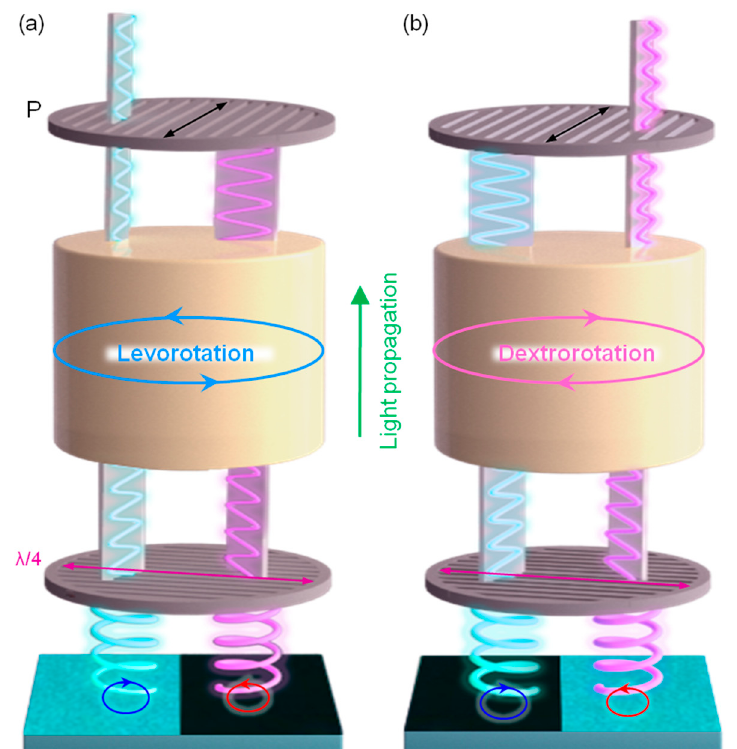
Figure 16. Chiral sensing applications of aligned D-9 film using optical rotation. Schematic illustration of the experimental setup of a chiral detecting tool and optical rotation of the polarized light when the solution (yellow cylinder) contains ( a ) ( − ) or ( b ) ( + ) chiral material, respectively. Depending on the chirality of the solution, the brightness of each chiral domain changes. Reprinted with permission from [20], Copyright 2019, Wiley-VCH.